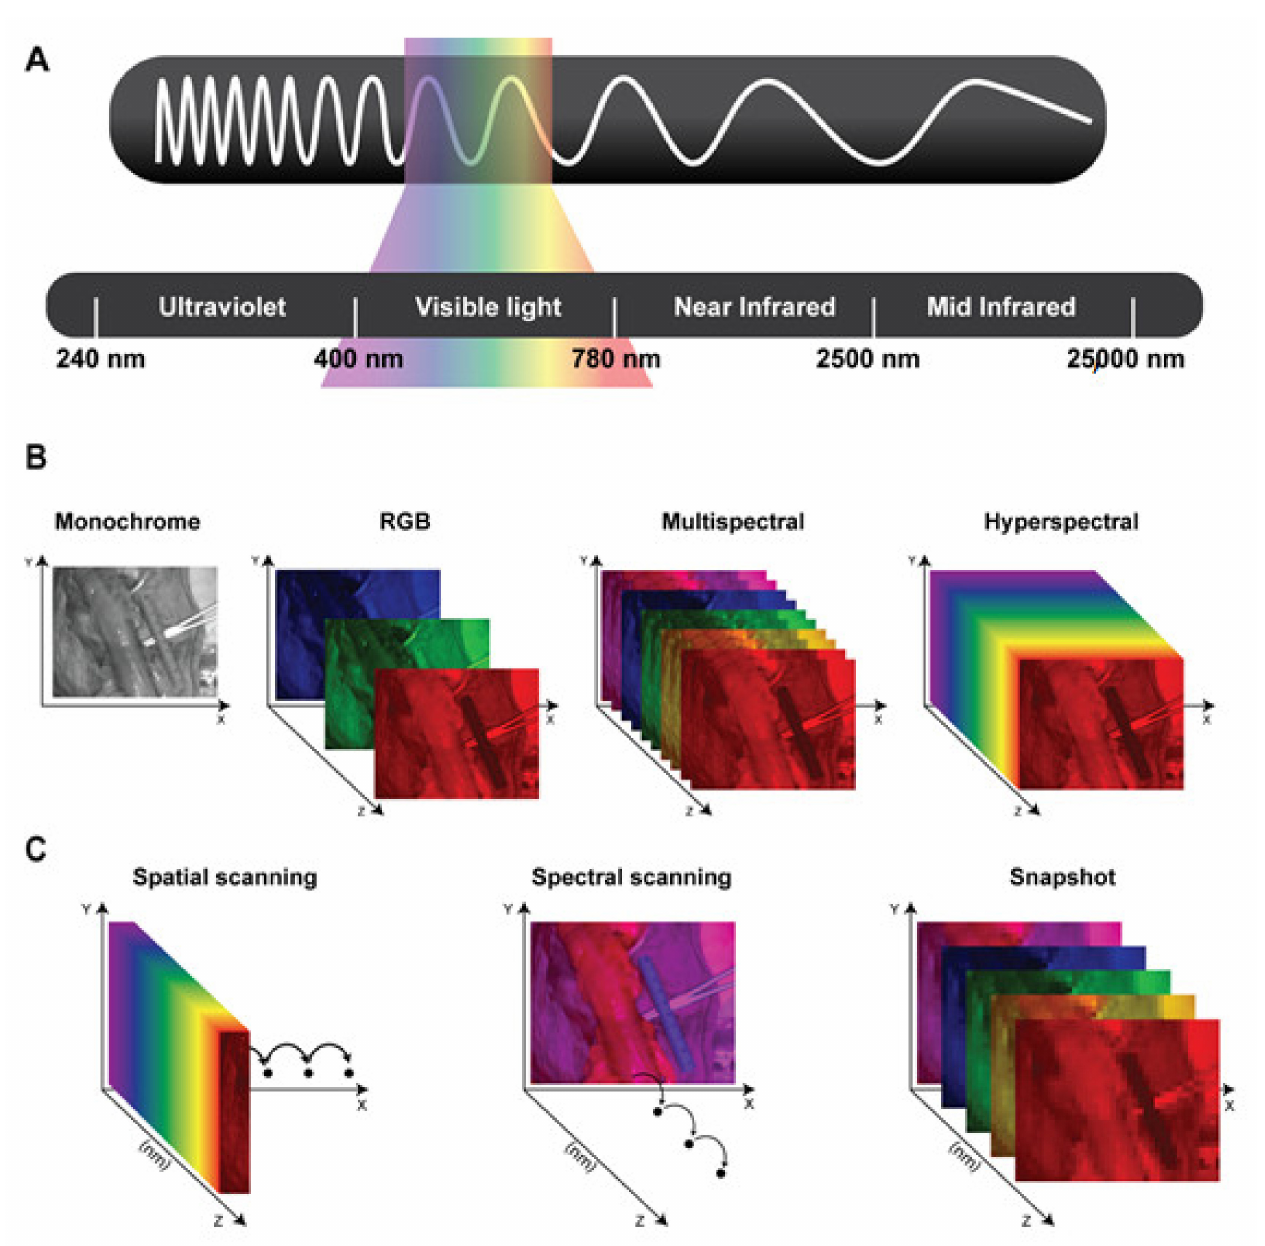
Figure 1. ( A ) Schematic representation of the electromagnetic spectrum’s wavelengths: Ultraviolet (240–400 nanometers), Visible light (400–780 nanometers), Near-Infrared (780–2500 nanometers, Mid- Infrared (2500–25000 nanometers). ( B ) Representation of the different datasets generated using: monochrome images; color or RGB (Red, Green, and Blue) images; multispectral and hyperspectral imaging. ( C ) Schematic representing the 3 different types of hyperspectral imaging devices. Spatial scanning: acquiring the spectral information as a whole and progressively scanning the spatial information. Spectral scanning: acquiring the spatial information as a whole and scanning the spectral one. Snapshot: simultaneously acquiring spectral and spatial information but providing a lower spatial and spectral resolution than previously mentioned hyperspectral